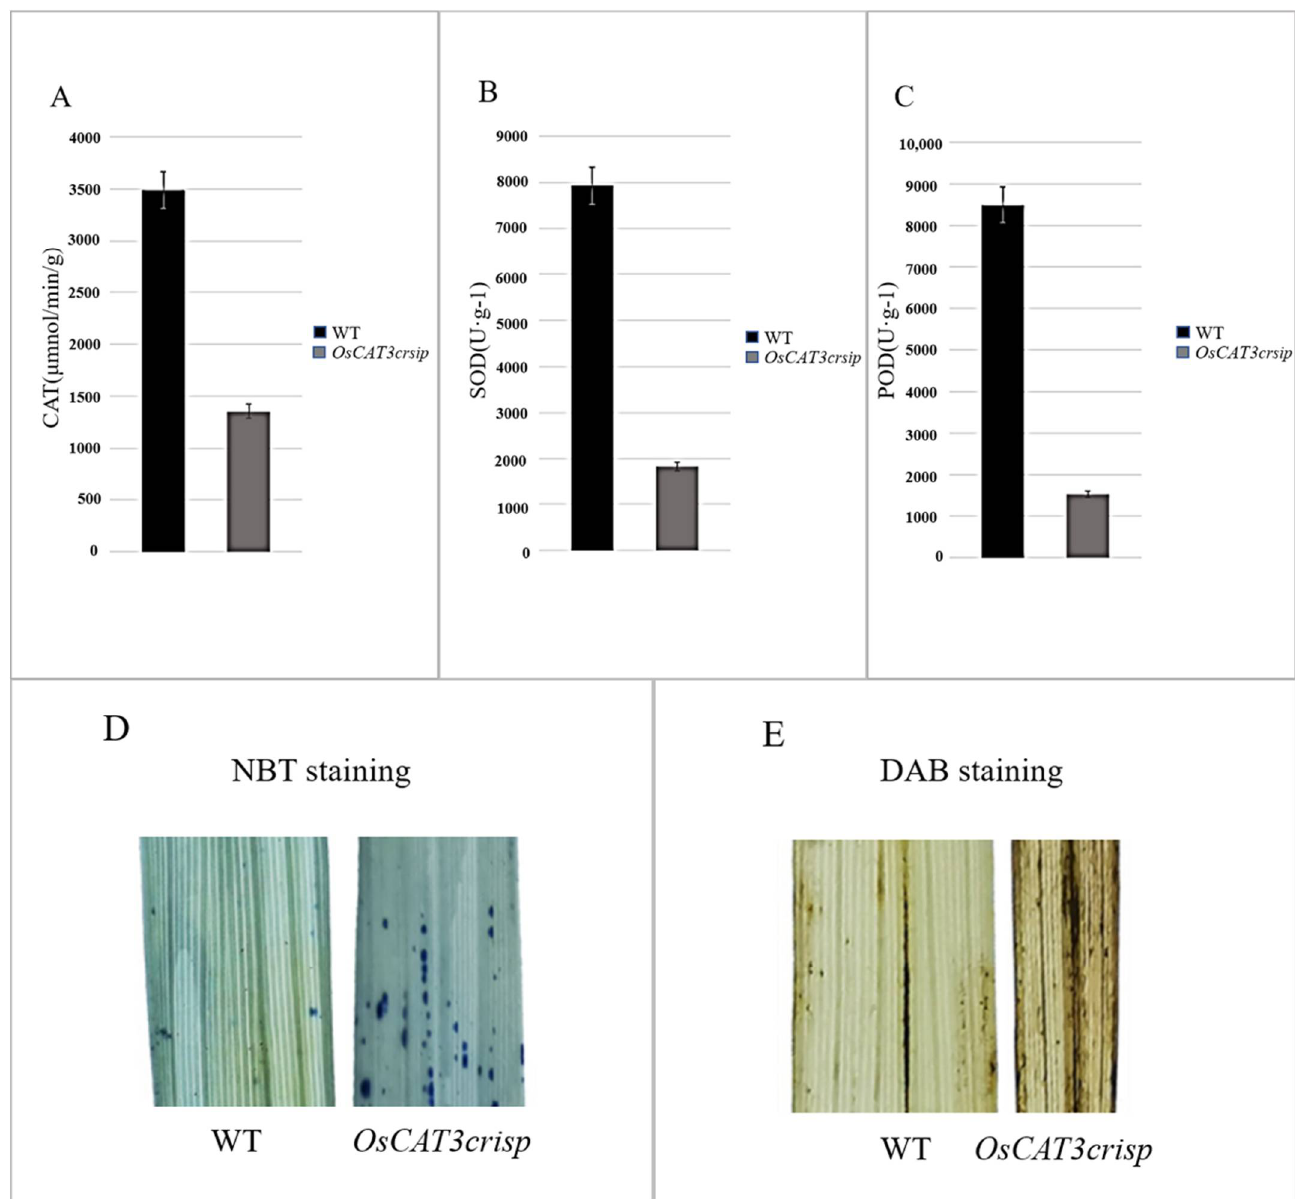
Figure 7. Enzyme activity determination and staining of OsCAT3 crispr transgenic rice. (A–C): De- creased antioxidant activity of CAT ( A ), SOD ( B ) and POD ( C ) in OsCAT3 crispr plant. Error bars represent SD of three independent experiments. ( D ): NBT staining showing O 2− accumulation in OsCAT3 crispr leaves. ( E ): DAB staining showing H 2 O 2 accumulation in OsCAT3 crispr leaves.